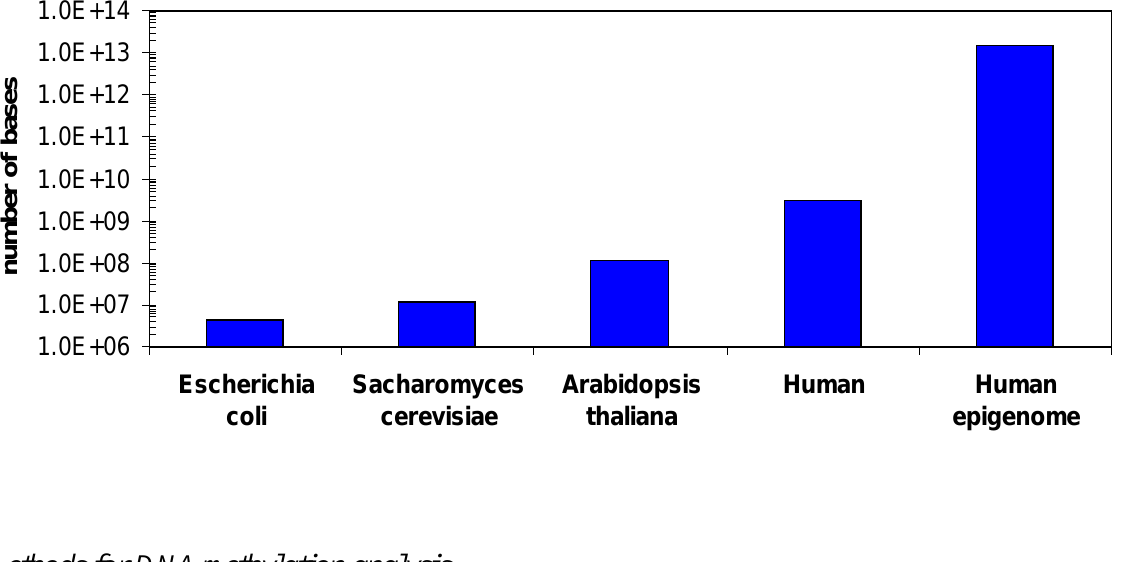
Figure 1 . Comparison of the sizes of different genomes and the human epigenome. A minimum epigenome size was estimated considering 100 different cell types and 50 relevant developmental or disease specific